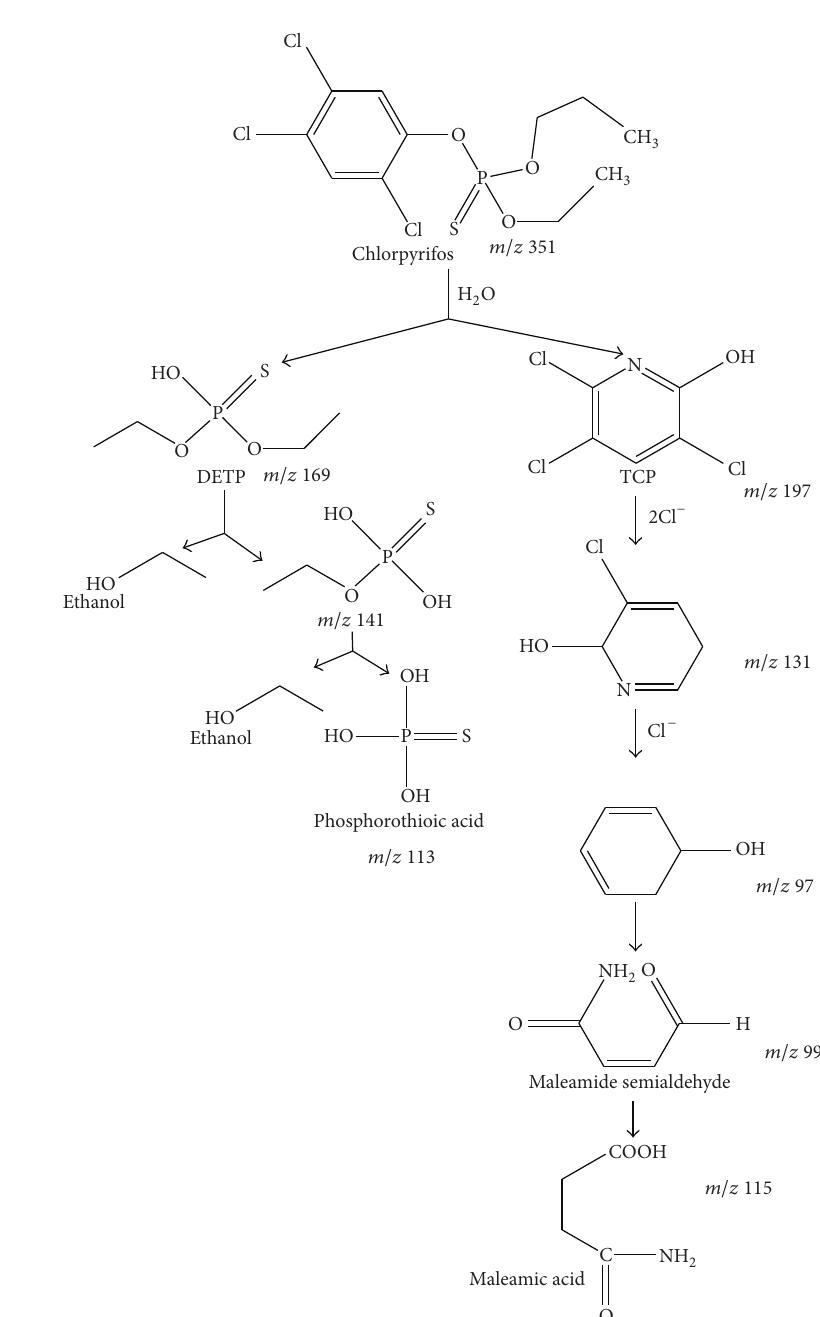
F 6: Proposed pathway for the degradation of chlorpyrifos by ZVNI